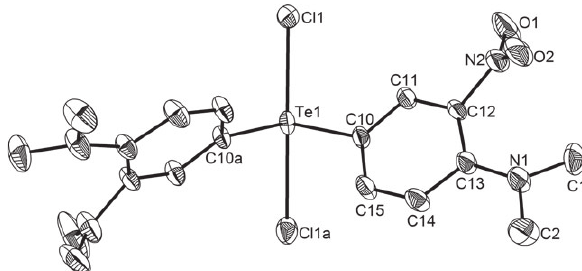
Table 1 Crystal data and structure refinement of [(4-Me